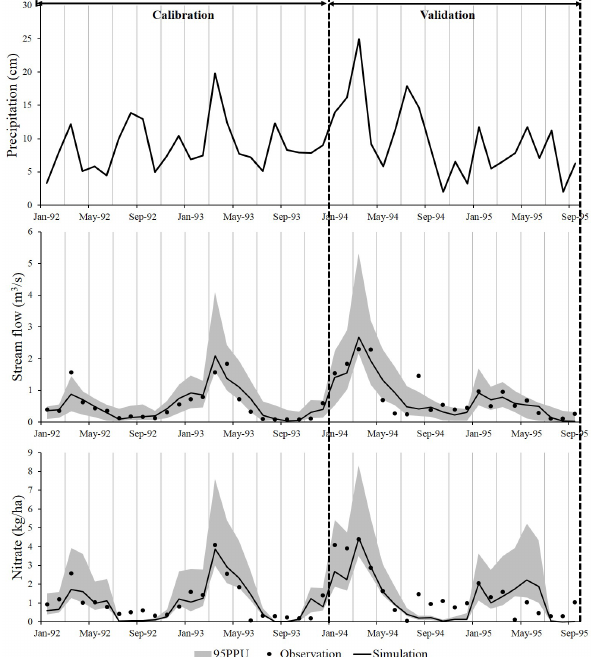
Figure 4. Observed and simulated monthly streamflows and nitrate loads during the monitoring period (1992–1995) at the watershed